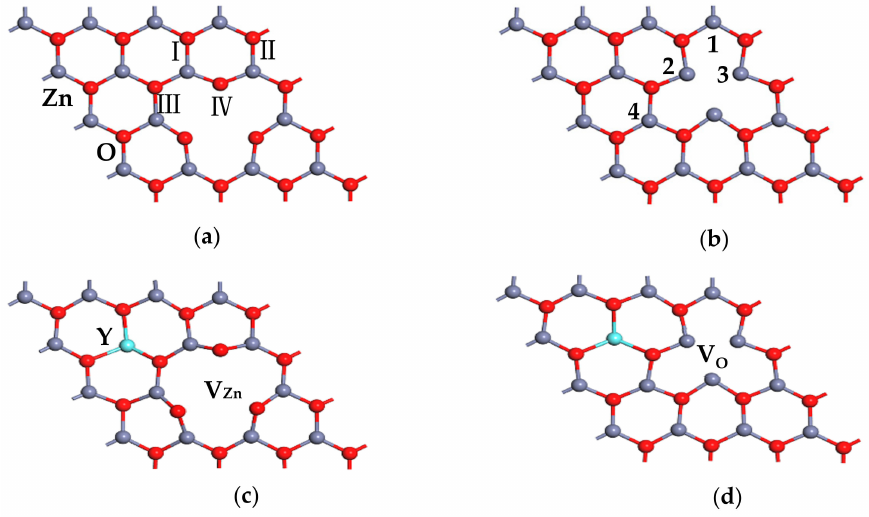
Figure 3. The optimized ZnO MLs with ( a ) V Zn , ( b ) V O , ( c ) Y and V Zn , ( d ) Y and V O